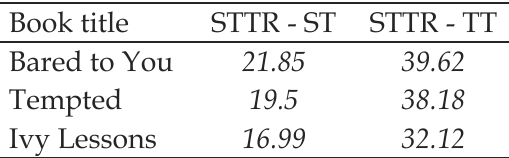
Standardised Type-Token Ratio per 10 000 words for English Source Texts